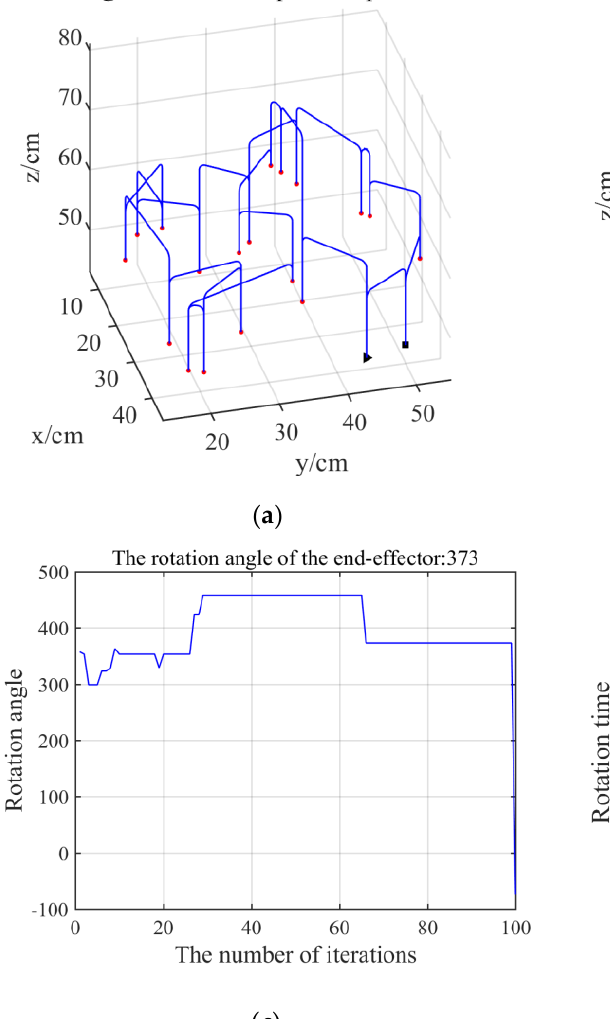
Figure 16. The fixed plane ∩ -shaped picking track planning results: ( a ) Simulation of picking path results; ( b ) Path length change curve; ( c ) Sum of waiting times of shortest paths.